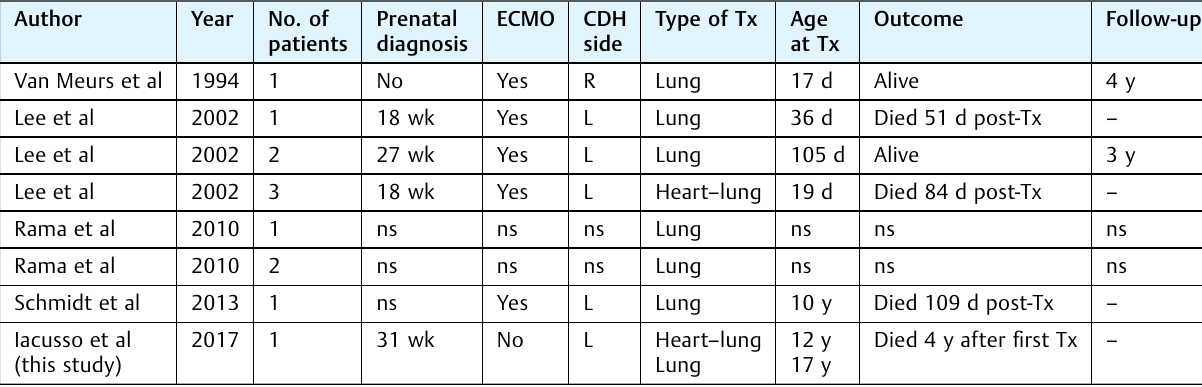
Table 1 Literature review of CDH patients who underwent lung or heart-lung transplantation